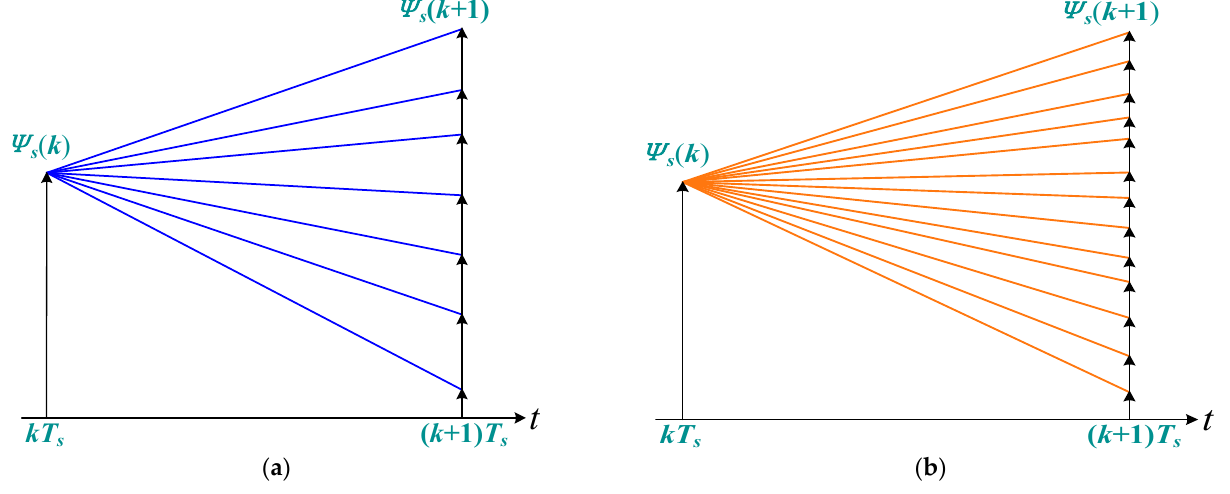
Figure 6. Different predictions of the stator flux linkage vector: ( a ) before; ( b ) after. The specific improvement methods are as follows: the two-level three-phase voltage source inverter can only produce eight switch states, according to the arrangement and combination, corresponding to six non-zero vectors and two zero vectors. In order to improve the accuracy of MPTC, six virtual voltage vectors are added to the traditional basic voltage vectors, which are half of the two adjacent synthesized voltage vectors, and the amplitude is 0.866 times that of the basic voltage vector. In this way, the number of alternative effective voltage vectors is changed from 6 to 12. The extended voltage vector control sets V 1 · · · V 12 are defined in Figure